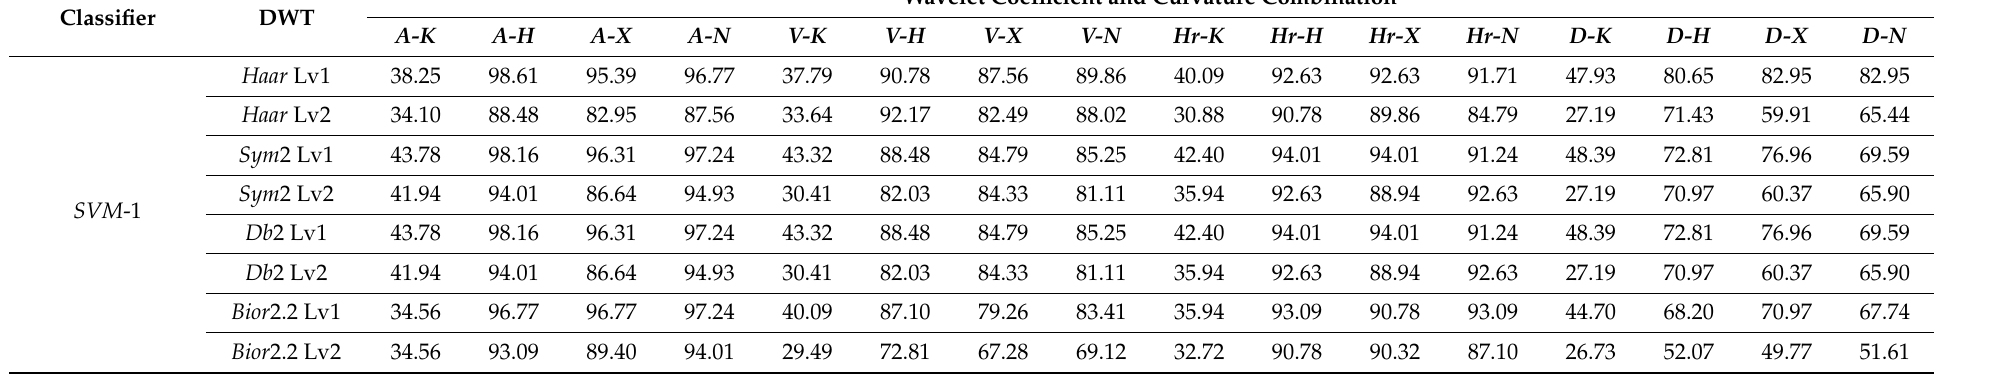
Table 10. The accuracy (%) results of combined DWT with a curvature-based method on the EYB dataset for the eyebrow images using SVM-1 . The combined methods produced wavelet coefficients with two decomposition levels and curvature-based variables (e.g., A-K (approximation with Gaussian curvature) until D-N (diagonal with min principal